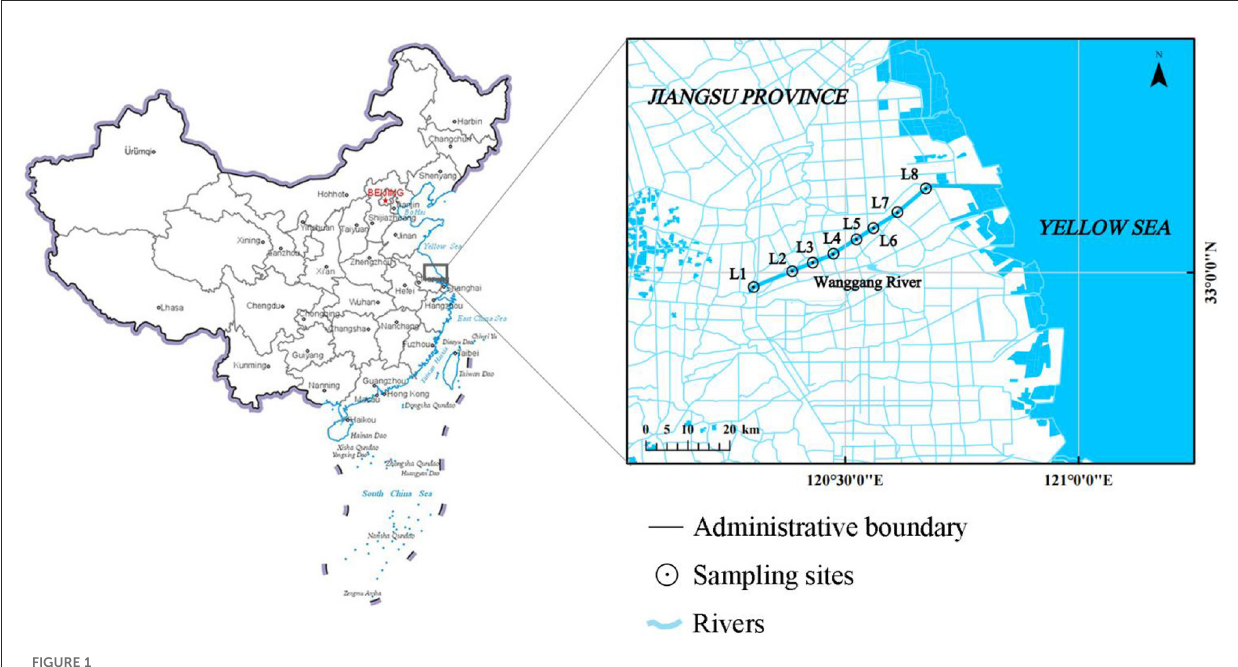
FIGURE1 Sampling locations in the Wanggang